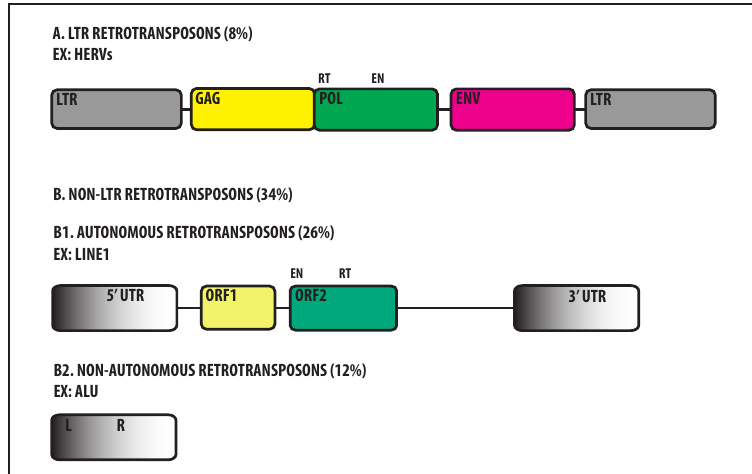
Main families of Retrotransposons. The retrotransposons are classified in two major classes. (A)The LongTandem Repeat retrotransposons have two identical tandem repeats ( LTR ) at each end of their se- quence, serving as promoters and transcriptional termination signals.They have three main genes for structural proteins ( Gag ), the replication enzymes ( Pol ), namely re- verse transcriptase ( RT ) and endonuclease ( EN ), and often the remnants of the enve- lope ( Env ). (B)The non-LTR retrotransposons are further segregated into autonomous and non autonomous.The autonomous non-LTR retrotransposons (B1) have a 5’ untranslated region (5’ UTR) driving transcriptional activity, 2 genes ( Orf1 and Orf2 ) of which Orf2 contains the endonuclease ( EN ) and reverse transcriptase ( RT ) activities, and a 3’ UTR.The non-autonomous retrotransposons (B2) have dual monomers for transcriptional activity but no genes. Adapted from Kazazian [3].